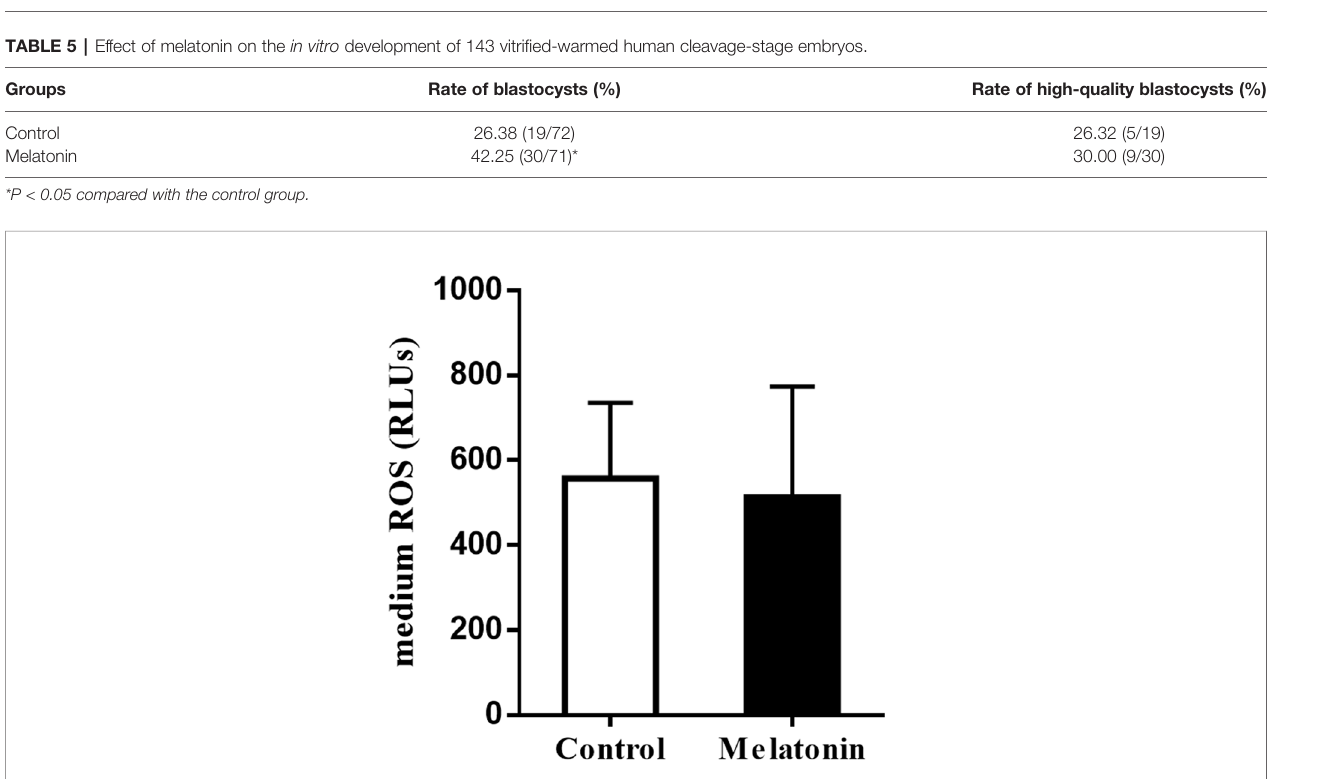
FIGURE 2 | Effects of melatonin on the ROS levels of culture media culturing vitri fi ed-warmed human cleavage-stage embryos for 72 h. Control: the ROS levels of culture media supplemented with no melatonin; Melatonin: the ROS levels of culture media supplemented with 10 -7 M